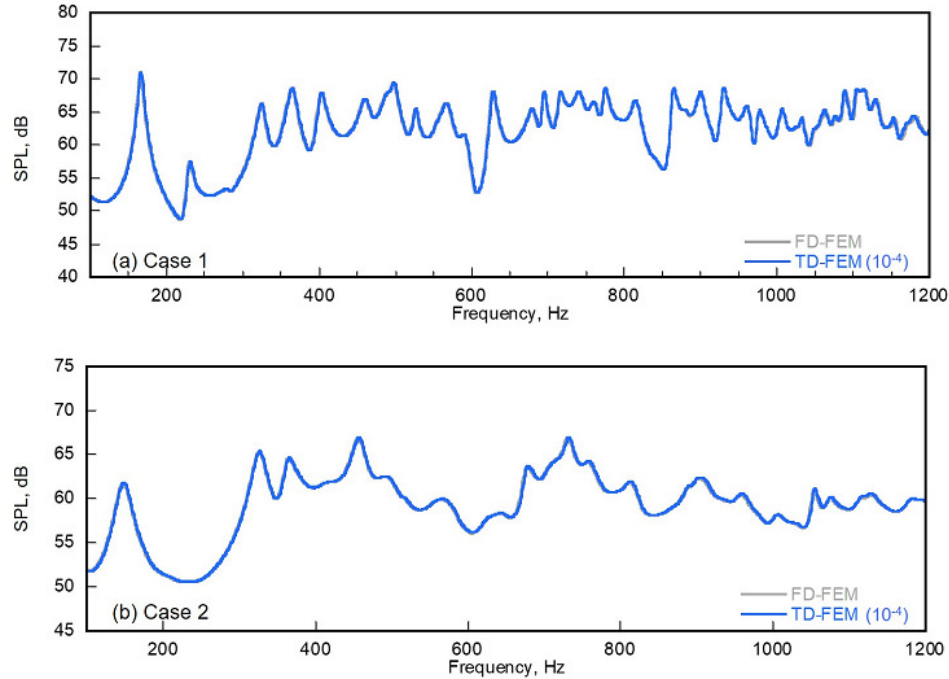
Figure 6. Comparisons of mean SPLs between the FD-FEM and the 4th-E TD-FEM with convergence tolerance of 10 − 4 for ( a ) Case 1 and ( b ) Case 2, where the values in parentheses following TD-FEM represent the convergence tolerance for CR